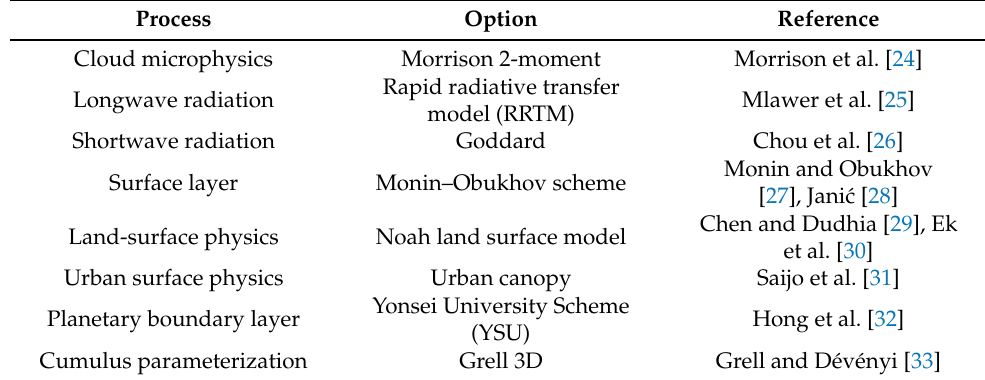
Table 2. Options used for parameterizations of atmospheric processes in the WRF-Chem